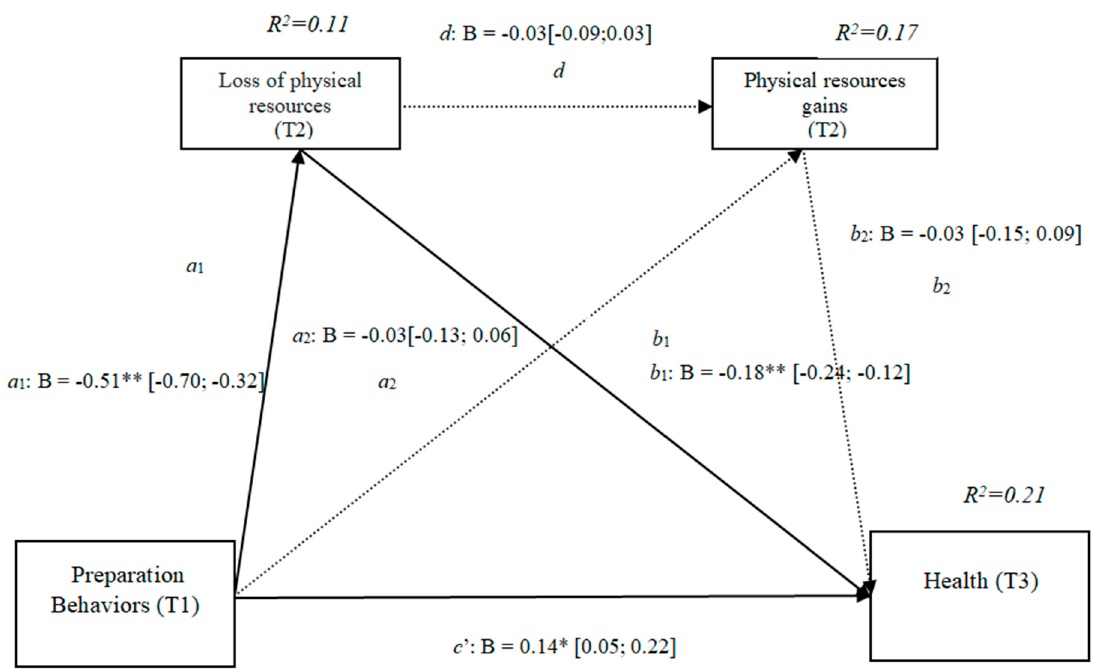
Figure 8. Non-standardized B coefficients, confidence intervals, and statistical significance for physical losses and gains. Note: [95% CI]; * p < 0.05; ** p < 0.01.